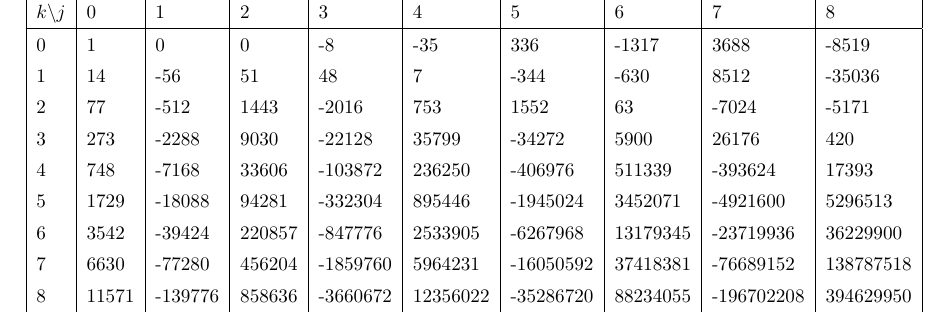
Table 54. Table of b jk coe(cid:14)cients for h G 2